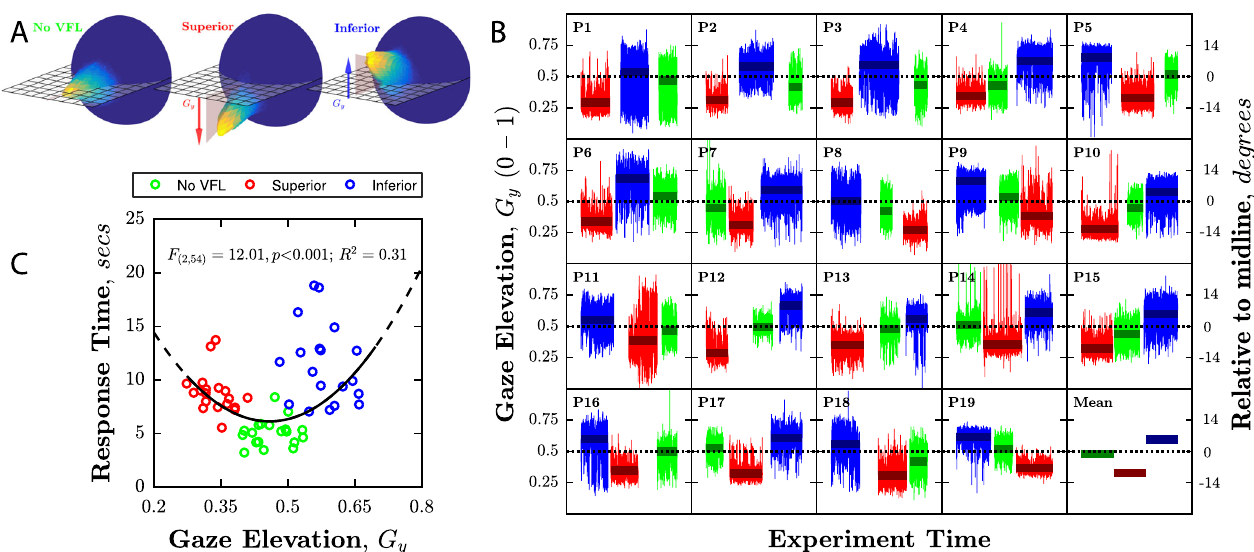
Fig. 5 Looking behaviors during VR search task. a Eyeball orientation in each condition. Each plot is a 3D histogram showing the estimated gaze vector, as measured every 8.3 msec throughout the experiment (~500,000 data points per plot, data averaged across eyes, data from all 19 participants included). These histograms show that participants tended to look downwards in the Superior VFL condition, and upwards in the Inferior VFL condition. b Gaze elevation (in normalized screen units, 0 – 1) as a function of time for each participant, and the group-mean value across all participants (bottom-right). The 0.5 point indicates the midline of the head-mounted display screen (central fi xation). A value of 0.75 indicates fi xation around the upper quarter of the screen ( + 14° above the midline). c Response time as a function of gaze-elevation. Circles represent individual participants (one data-point per participant, per condition). The black curve indicates the best- fi tting quadratic model (weighted sum of squares, fi tted using bisquare